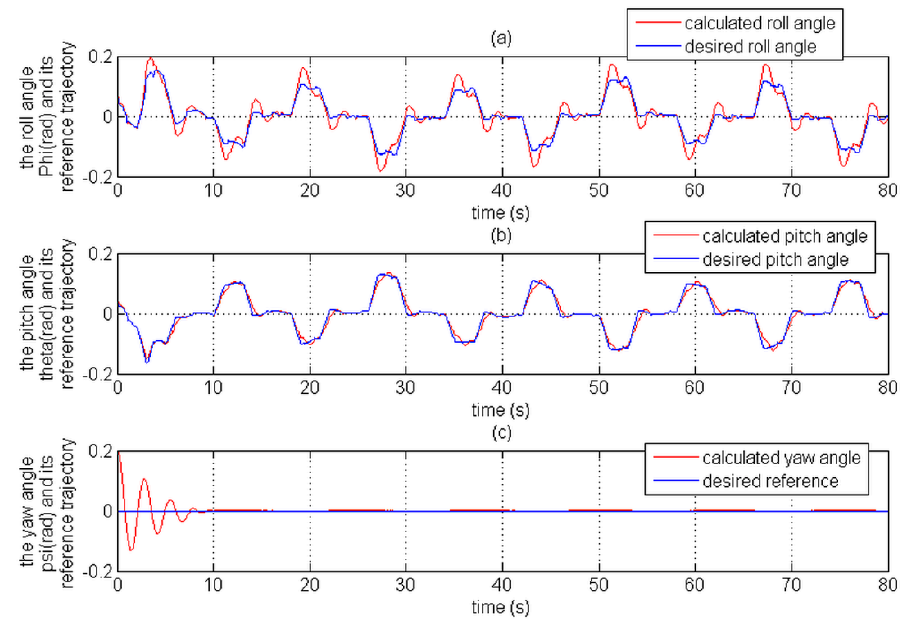
Figure 22. The attitude tracking evolution obtained by the CMTC: ( a ) roll angle evolution φ ( rad ) and its reference trajectory φ d ( rad ) ; ( b ) pitch angle evolution θ ( rad ) and its reference trajectory θ d ( rad ) ; ( c ) yaw angle evolution ψ ( rad ) and its reference trajectory ψ d ( rad )